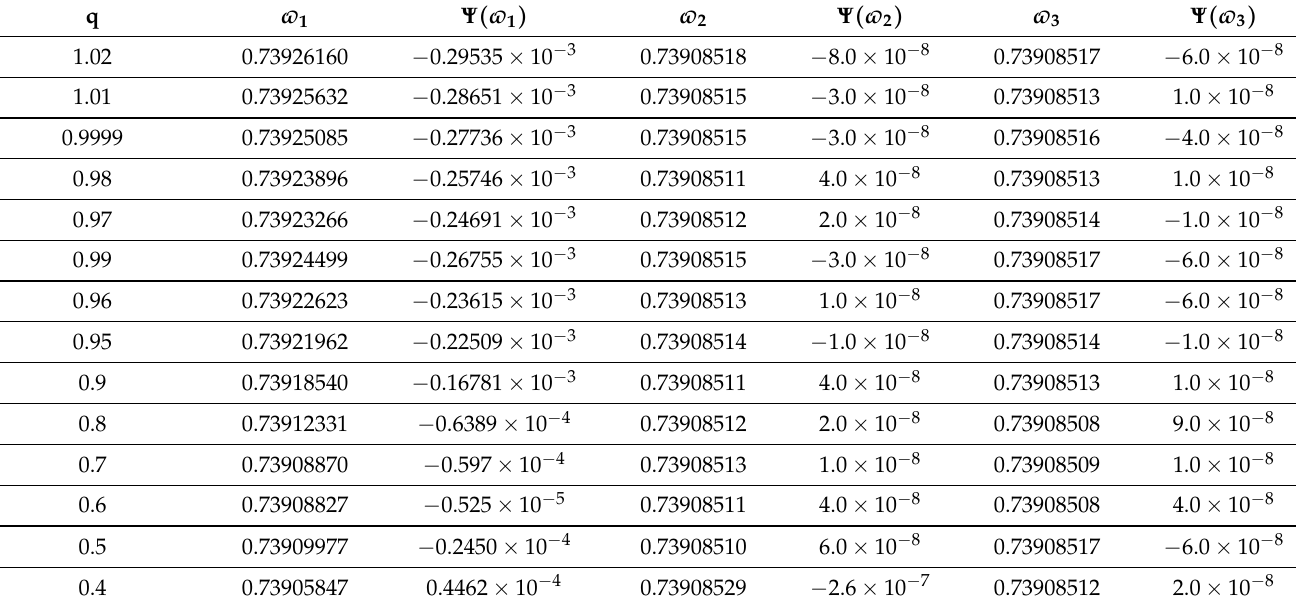
Table 4. Calculation of (cid:118) i and Ψ ( (cid:118) i ) for i = 1,2,3 and different values of q by using